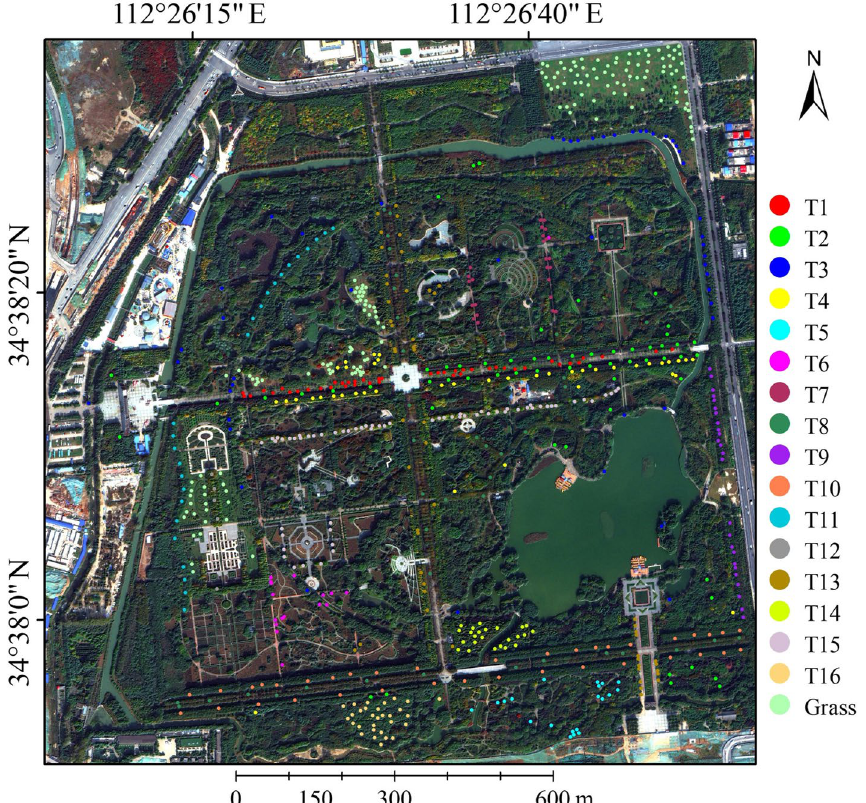
Fig. 1 Image of WorldView-3 (RGB 532 combination) in the study area with sample distribution of different tree species. T1–T16 represent the serial numbers of the 16 different tree species/bamboo to be classified. The dots of different colours in the image represent the collection locations of the corresponding tree species and grass